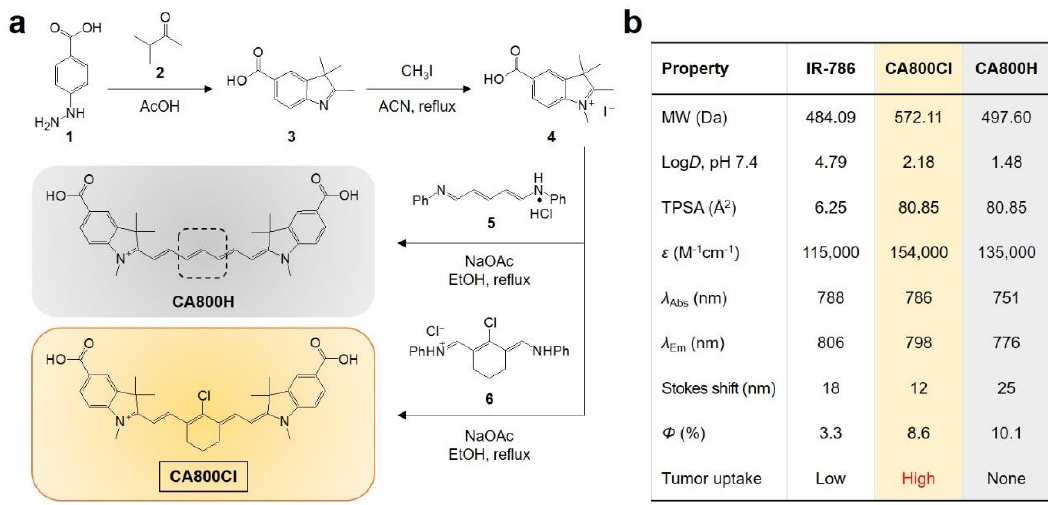
Figure 1. ( a ) Synthetic scheme of the CA800Cl and CA800H NIR fluorophores. ( b ) Physicochemical and optical properties of IR-786, CA800Cl, and CA800H NIR fluorophores. In silico calculations of the partition coefficient (log D at pH 7.4) and TPSA were calculated using Marvin and JChem calculator plugins (ChemAxon).